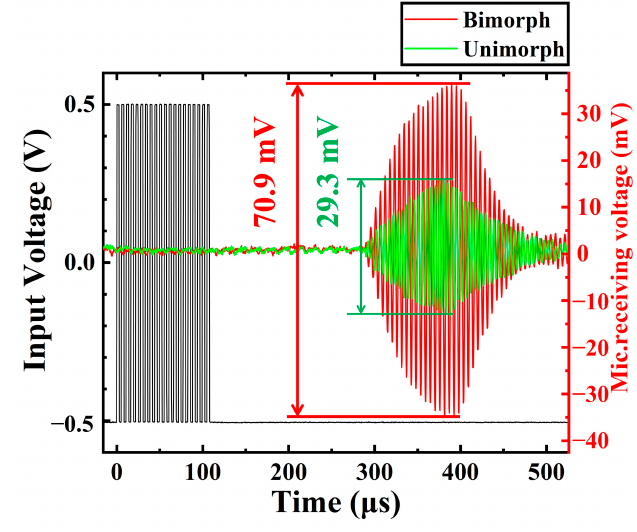
Figure 10. Device characterization for performance of transmitter.